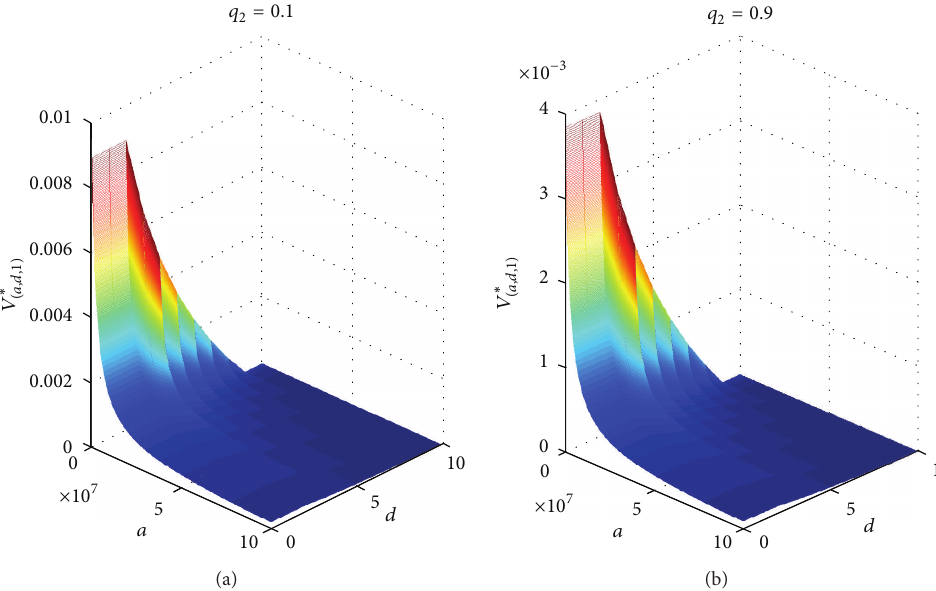
Figure 4: Whittle index values obtained from AG -algorithm for different channel state probabilities. For a Pareto distribution with 𝛼 = 1.5 and E [𝑋] = 5 Mb, 𝑟 1 = 8.4 Kb, 𝑟 2 = 16.8 Kb, 𝑑 min = 2 s, and 𝑑 max = 9